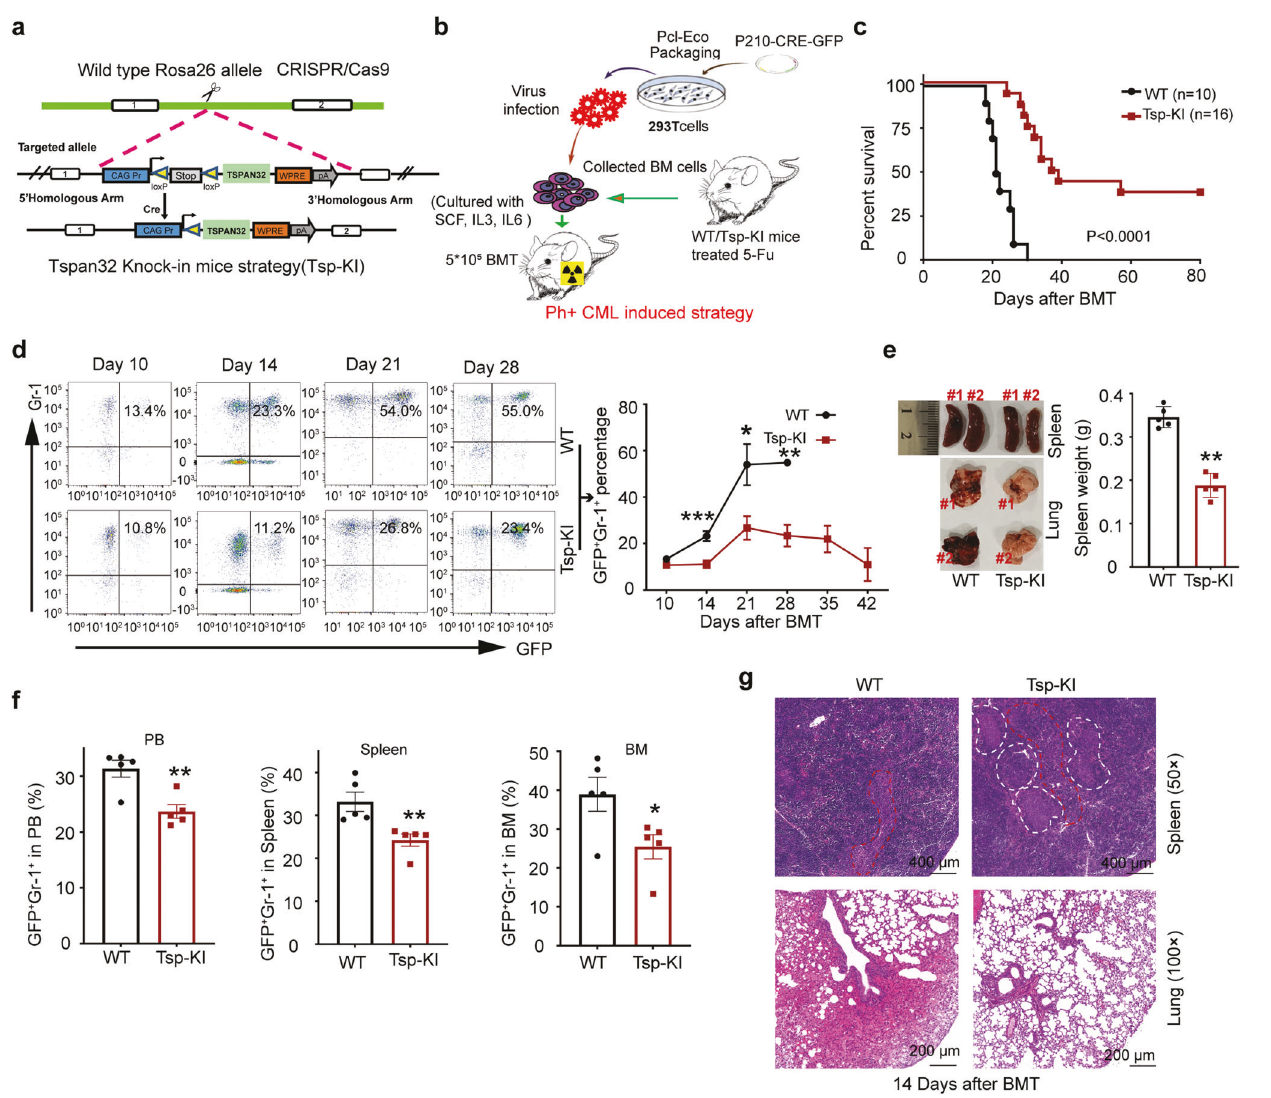
Fig. 3 Overexpression of Tspan32 hampers the progression of BCR-ABL induced CML. a Schematic diagram describing the Tspan32 knock-in mouse with the Roas26 allele. b Schematic diagram describing Tspan32 overexpression via Cre endonuclease in a P210-iCre-GFP induced CML mouse model. c Kaplan – Meier-style survival curves for WT or Tsp-KI group recipients. d GFP + Gr-1 + percentages in PB for all recipients induced (day 10, 14, 28 and 32 post BMT). CML mice were induced, recipients from both groups were sacri fi ced on day 14 post BMT for the leukemia burden analysis (and in fi ltration in spleen and BM). e FACS analysis percentage for GFP + Gr-1 + cells in PB, Spleen and BM ( n = 5 per group). f Gross appearances of lung and spleen, and spleen weight. g Photomicrographs for H&E-stained of spleen and lung sections. The white dotted line represents the white pulp of spleen, and red dotted line represents the red pulp of spleen. Error bars denote mean ± SEM, * P < 0.05, ** P < 0.01, *** P < 0.001 ( T